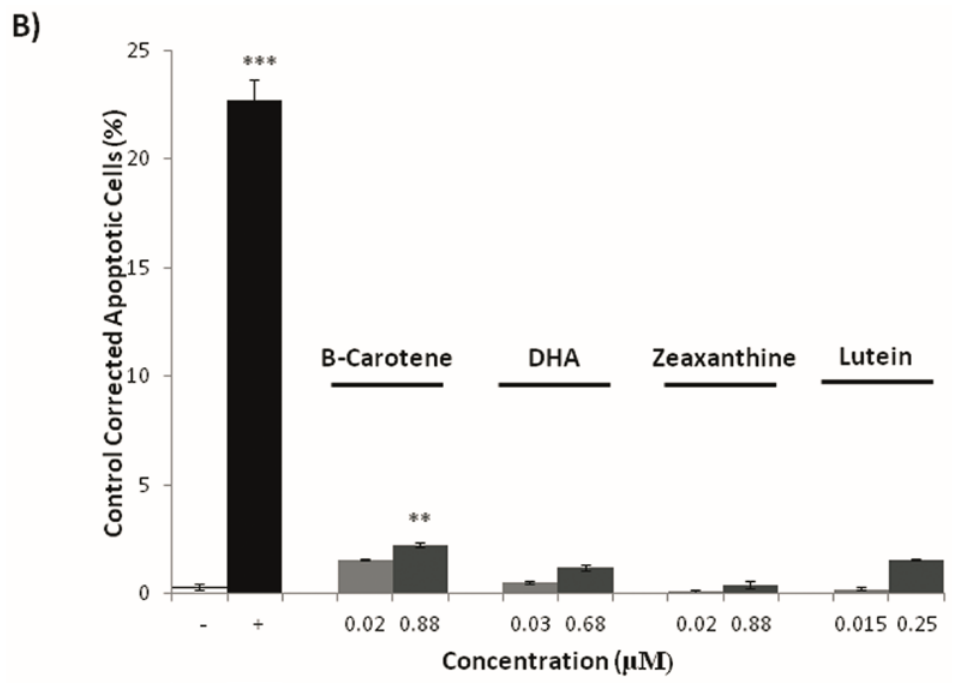
Figure 7. Analysis of cell death apoptotic way in HL60 cells by Annexin V-PI staining after 5 h of treatment with different concentrations of: YZE (yellow zucchini epicarp), YZM (yellow zucchini mesocarp), LGZE (light green zucchini epicarp), and LGZM (light green zucchini mesocarp) ( A ); and different carotenoids and DHA (dehydroascorbic acid) ( B ). -: negative control; +: positive control; ** p ≤ 0.01; *** p ≤ 0.001